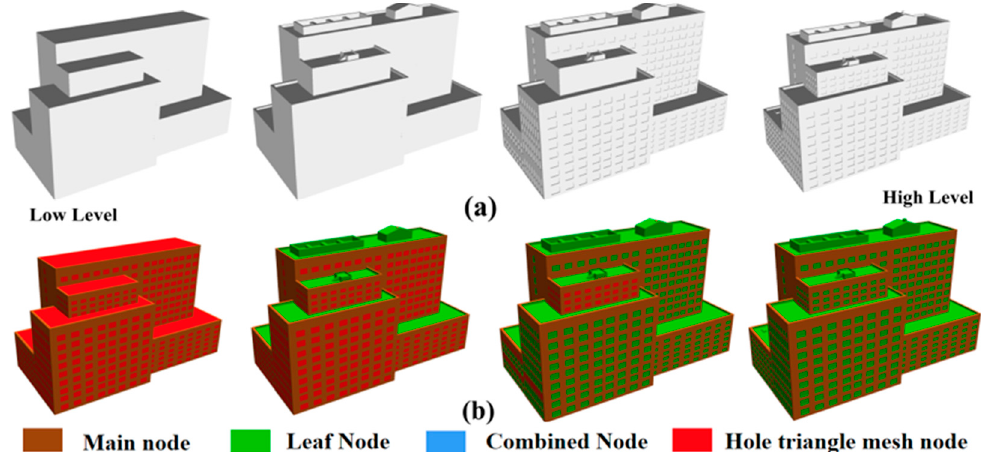
Figure 12. Model 1 refines from a low-level model to a high-level model by receiving increments. ( a ) Geometric structure change of Model 1, and ( b ) Model 1 receives various transmission nodes.